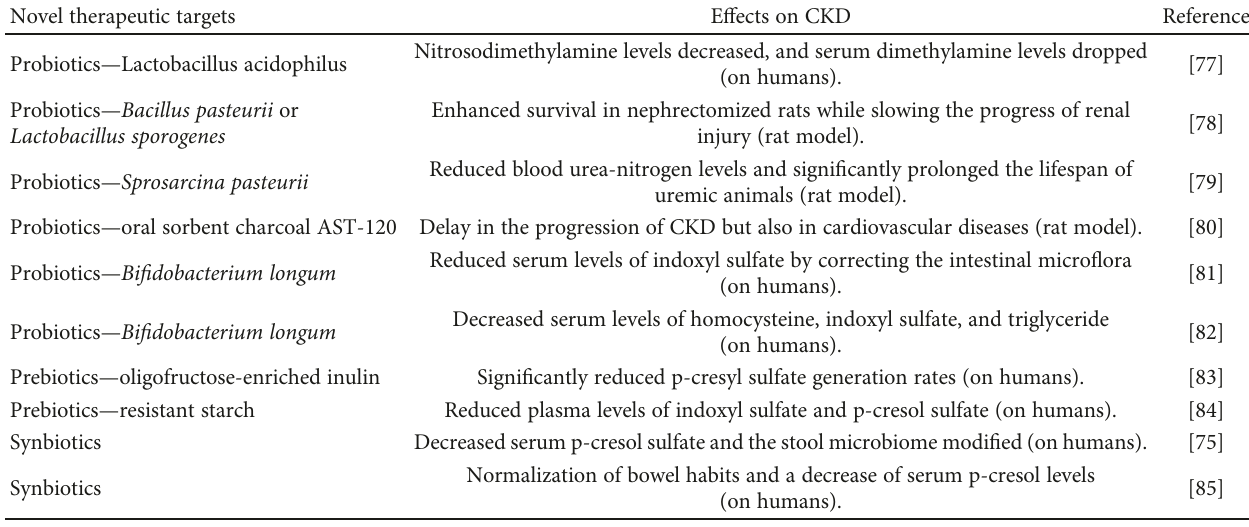
Table 1: E ff ects of administrating pro-, pre-, or synbiotics in